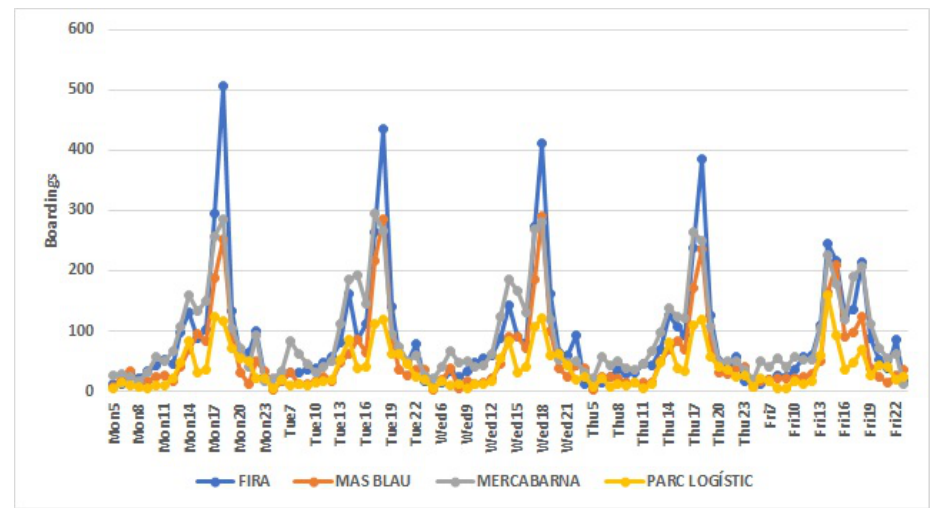
Figure 16. Pattern of boarding stations of Cluster 4